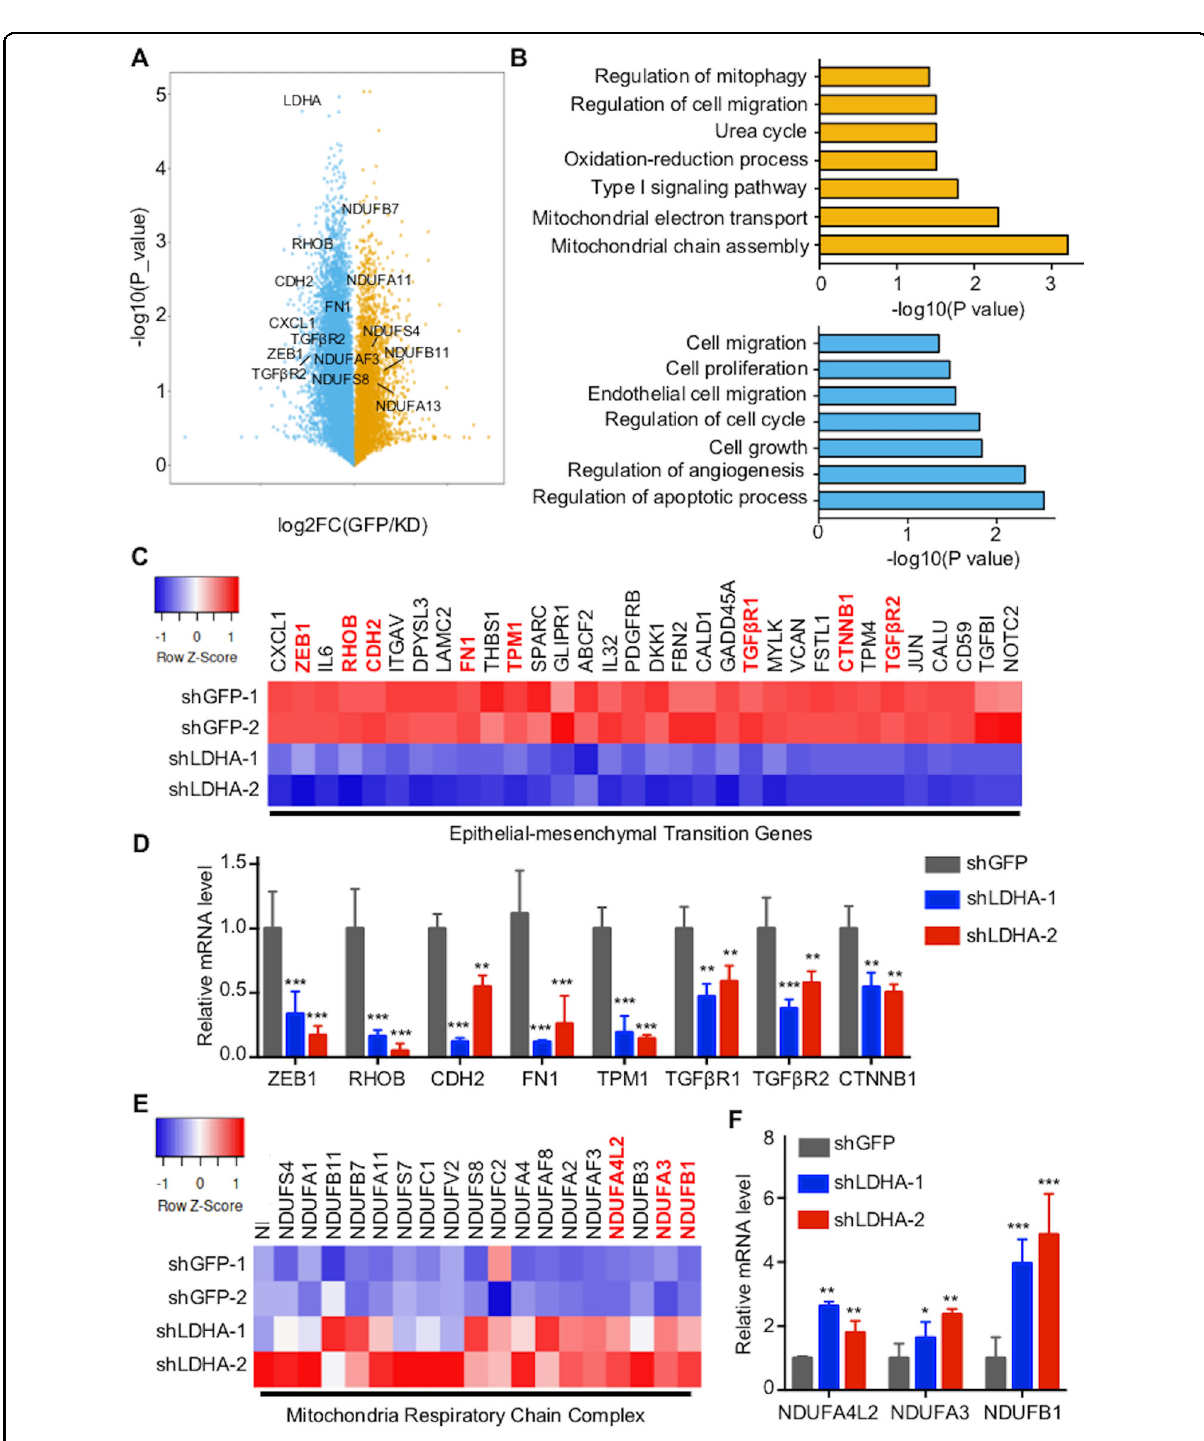
Fig. 5 Discovery of LDHA regulated genes in PTC. A Volcano plot of the gene expression changes that occurred after LDHA knockdown in B-CPAP cells assayed by RNA-Seq. B Summary of the signi fi cantly enriched pathways in B-CPAP cells after LDHA knockdown. C Heatmap from the RNA-Seq data showing the differentially expressed genes involved in the EMT process. D qPCR analysis of representative genes related to the EMT process after LDHA knockdown. The expression data were normalized to that of Actin in GFP knockdown cells. E Heatmap of the RNA-Seq data show that the differentially expressed genes were related to the mitochondrial respiratory chain complex. F qPCR analysis of representative genes related to the mitochondrial respiratory chain complex after LDHA knockdown. All * p < 0.05, ** p < 0.01, *** p <